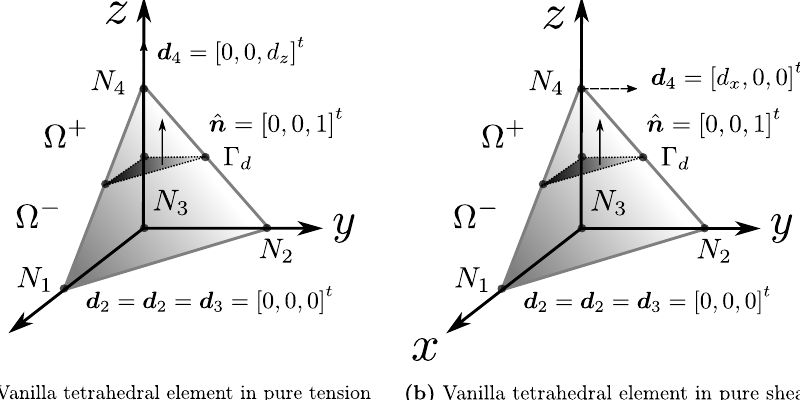
Figure 12. Schematics of typical vanilla elements taken for formulation testing at a small scale. Left element ( a ) for pure tension, right element ( b ) for pure